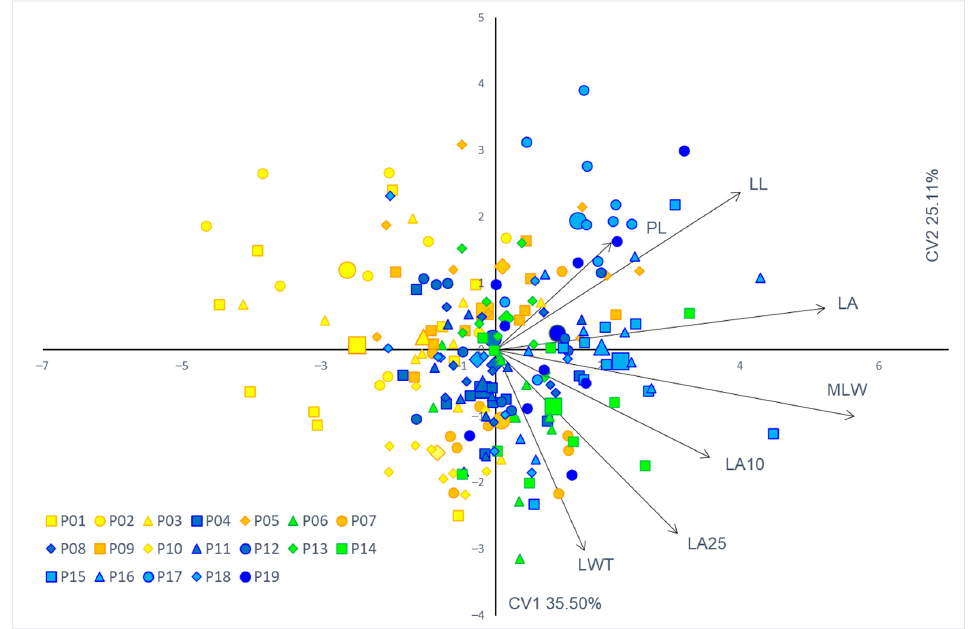
Figure 4. Discriminant analysis of 19 European wild pear populations based on seven leaf phenotypic traits that were the most useful for maximum discrimination between studied populations. Each individual tree is indicated by a small sign, while the population barycenters are represented by larger ones. Leaf phenotypic traits: LA—leaf area; LL—leaf length; MLW—maximum leaf width; LWT—leaf width top; PL—petiole length; LA10—angle closed by the main leaf vein (the center of the leaf blade) and the line connecting the leaf blade base to a set point on the leaf margin at 10% of total leaf blade length; and LA25—angle closed by the main leaf vein (the center of the leaf blade) and the line connecting the leaf blade base to a set point on the leaf margin at 25% of total leaf blade length. Canonical discriminant variate